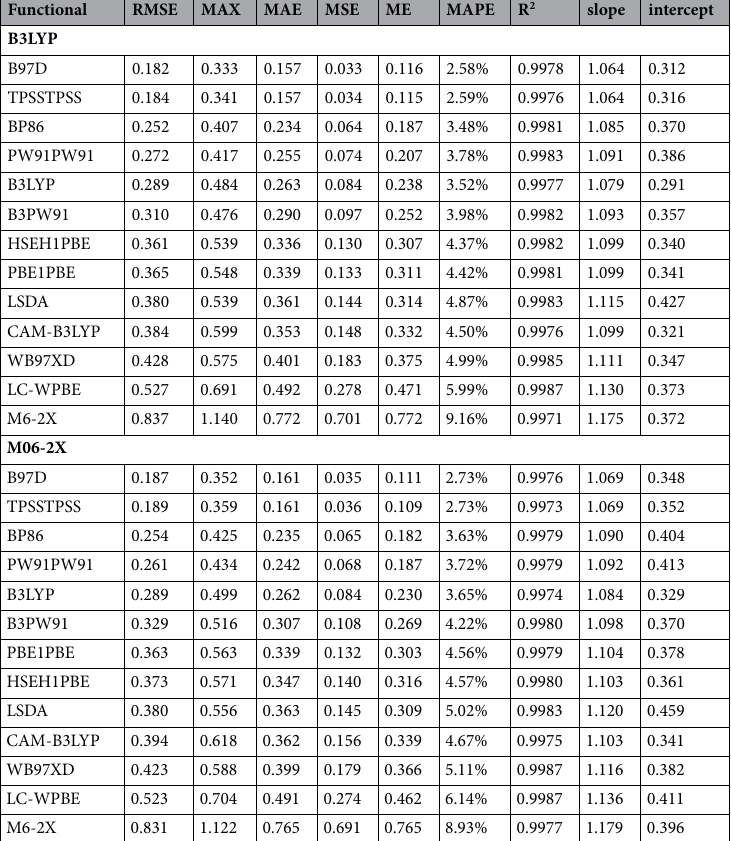
Table 1. The averaged descriptors RMSE, MAE, ME, MAX, MAPE, ME, R 2 , slope, and intercept computed for 1 H-NMR deviations for each combination of geometry level, basis set, and functional. The table is sorted by RMSE